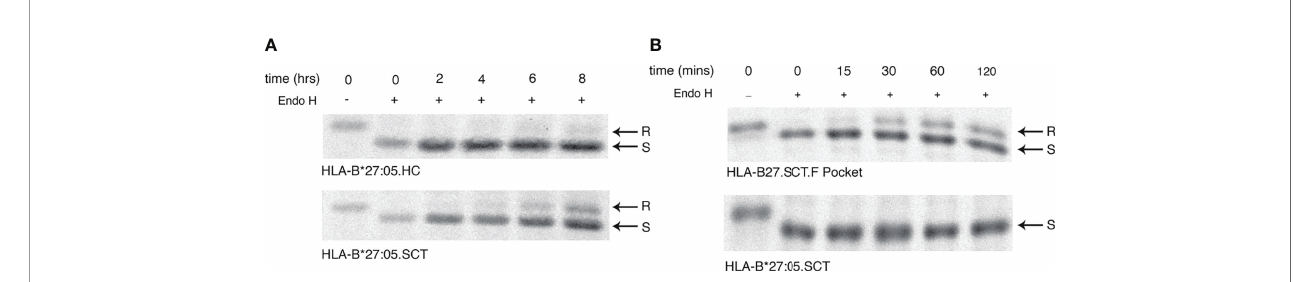
FIGURE 6 | F pocket substitutions alter the maturation rate of HLA-B27.SCT. (A) Pulse chase analysis over 8 hrs followed by endo H digestion of anti-V5 immunoprecipitates demonstrate that HLA-B*27:05.HC has a slow maturation phenotype. HeLa cells expressing HLA-B*27:05.HC and HLA-B*27:05.SCT were metabolically labelled with 35 S cys/met for 10mins, chased and immunoprecipitated with anti-V5 antibody for 0, 2, 4, 6 and 8 hrs, followed by digestion with endo H for 1hr at 37°C. Immunoprecipitates were resolved by reducing 8% SDS-PADE. Endo H sensitive (S) and resistant (R) conformers are indicated with arrows. The rate of endo H resistance acquisition by HLA-B*27:05.SCT does not signi fi cantly change until 8hrs of chase. (B) F pocket substitutions alter the maturation rate of HLA- B27.SCT. Pulse chase analysis over 120 mins reveals that the F pocket substitutions lead to the acquisition of endo H resistant (R) conformers after